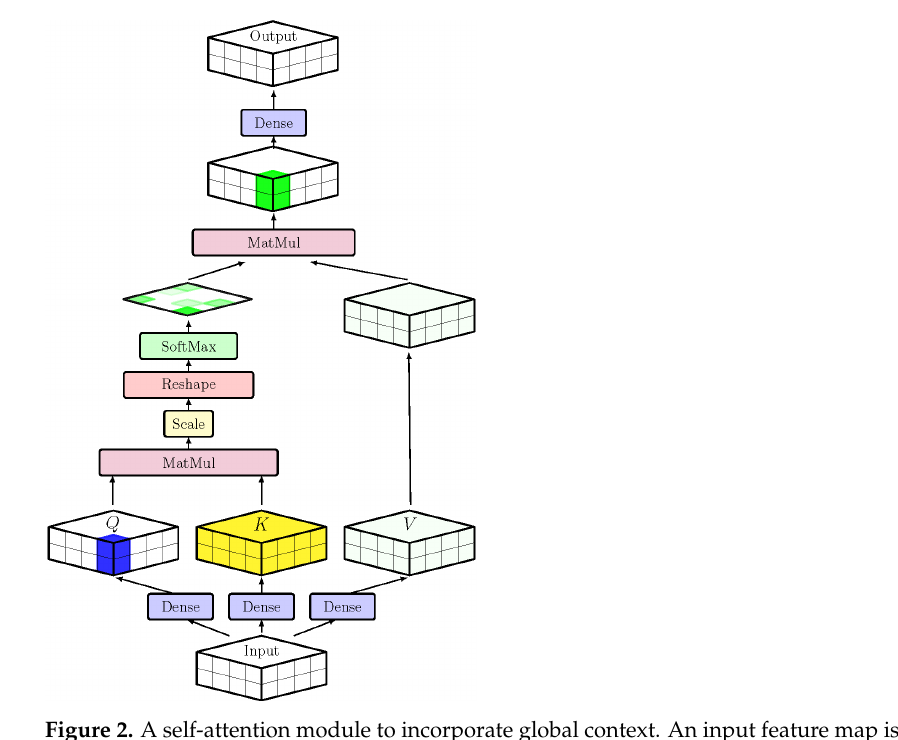
Figure 2. A self-attention module to incorporate global context. An input feature map is transformed to query Q , key K , and value V by fully connected layers. This self-attention module computes relationships among all elements of feature maps by query Q and key K , and then value V is blended by itself considering the computed relationships. Lastly, the fully connected layer is applied to recover channel dimensions and give the module a bottleneck